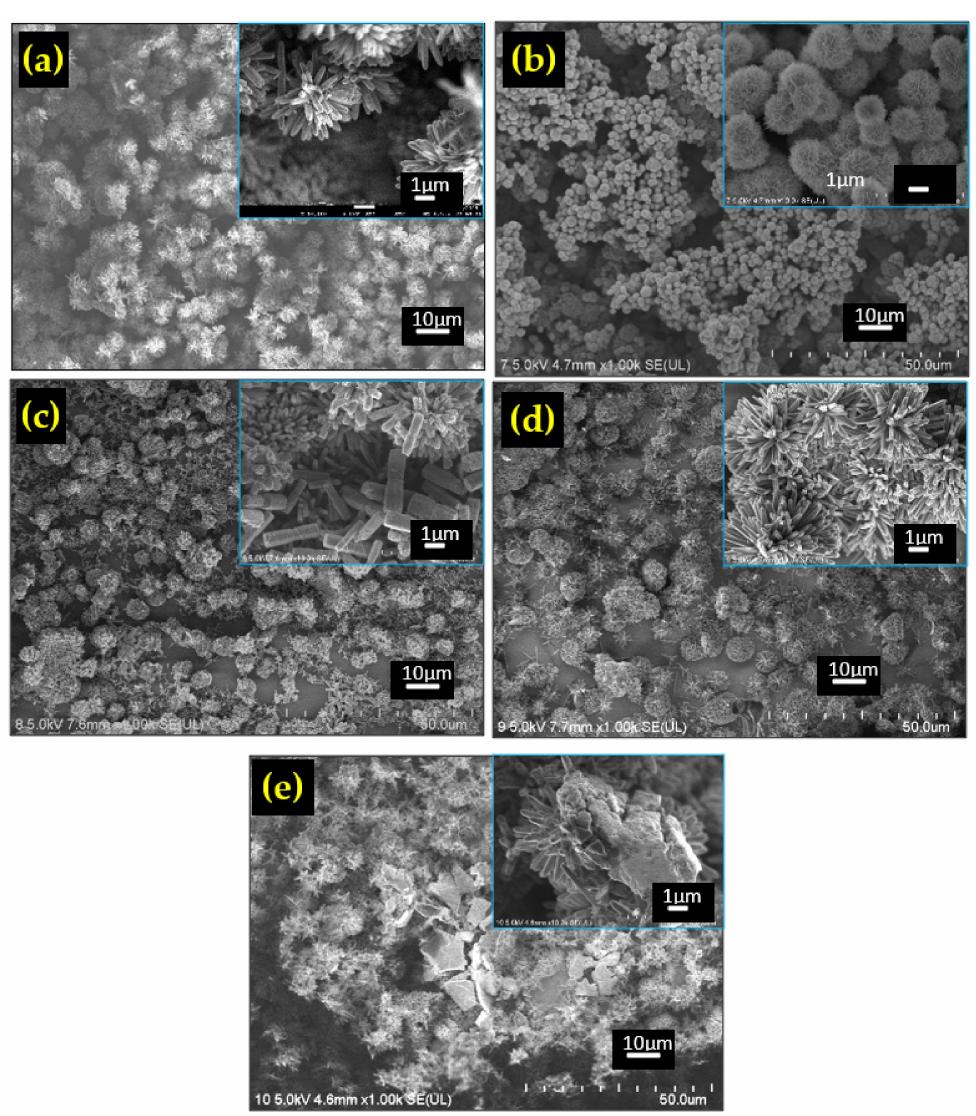
Figure 3. FESEM images of: ( a ) TiO 2 , ( b ) TiO 2 /NiO, ( c ) TiO 2 /ZnO, ( d ) TiO 2 /rGO, and ( e ) TiO 2